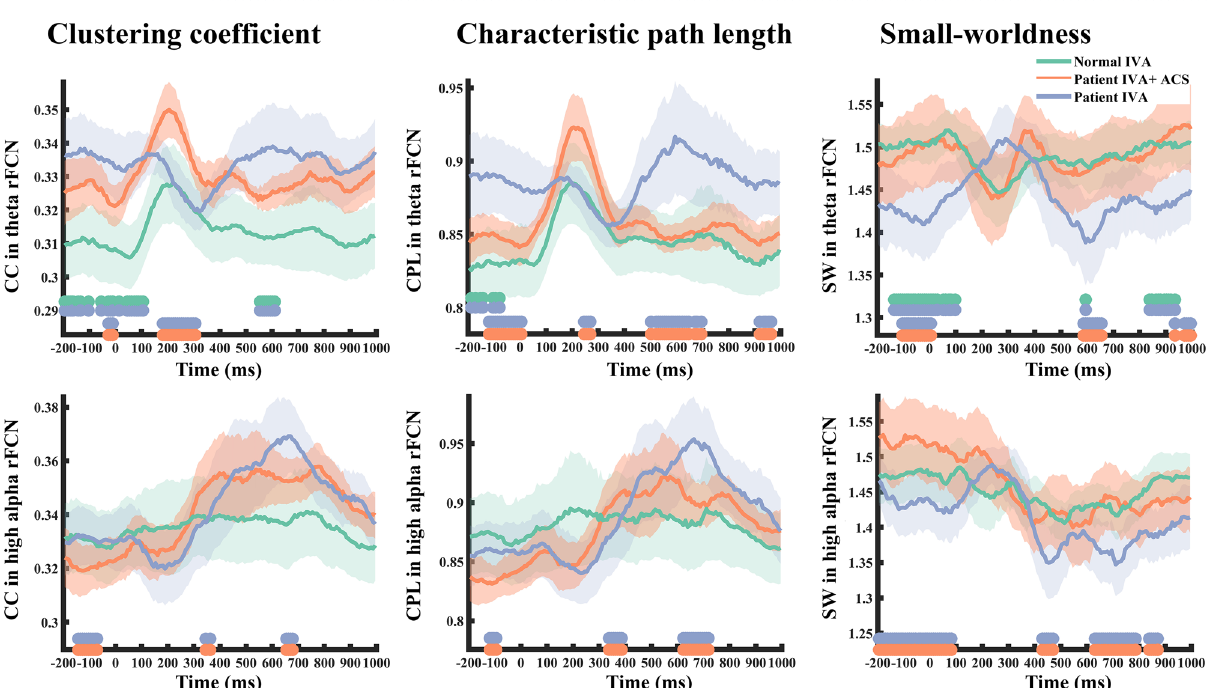
Figure 3. Transient dynamics of global rFCN parameters. Multiple global rFCN matrices change across time during visual processing in control subjects (green line) and patients with optic nerve damage pre- (blue) and post-rtACS treatment (red). The horizontal green–blue bars on the x-axis indicate time windows with significant differences between controls and patients; orange–blue bars mark significant differences of pre- vs. post- treatment (p <